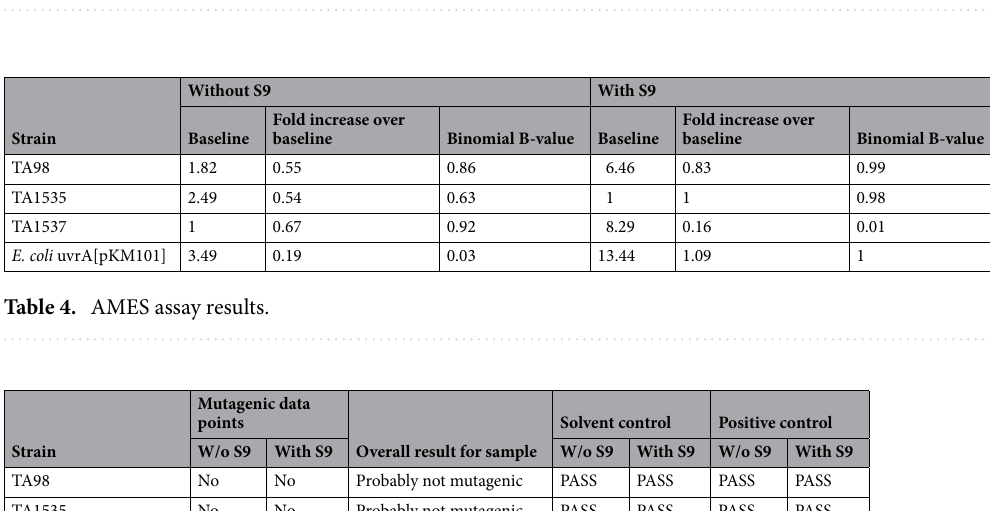
Figure 2. Images of cells after exposure to surgical adhesive extracts, negative and positive controls in the MEM elution study.